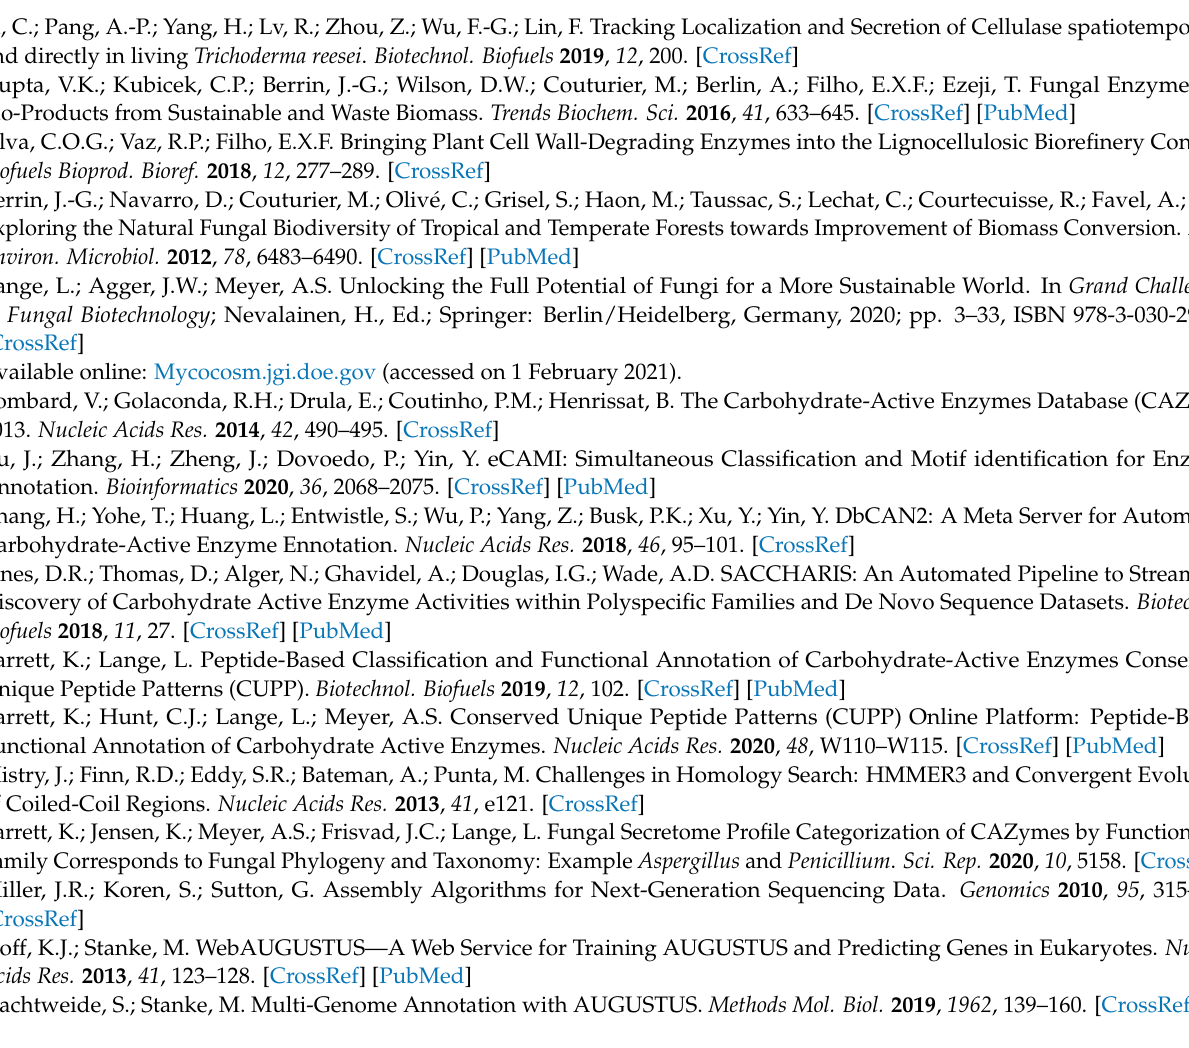
Table S3: Categorization of “Family;Function” of enzymes in relation to substrate